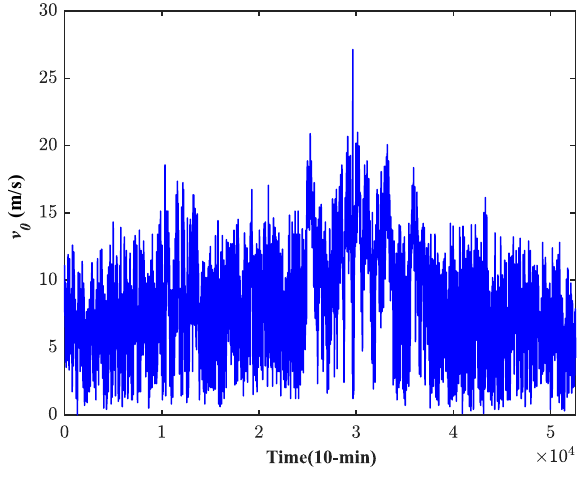
Figure 3. Wind speedprofile for a year. Table 1. Specifications of the used wind turbine, PV module, BESS, and inverter